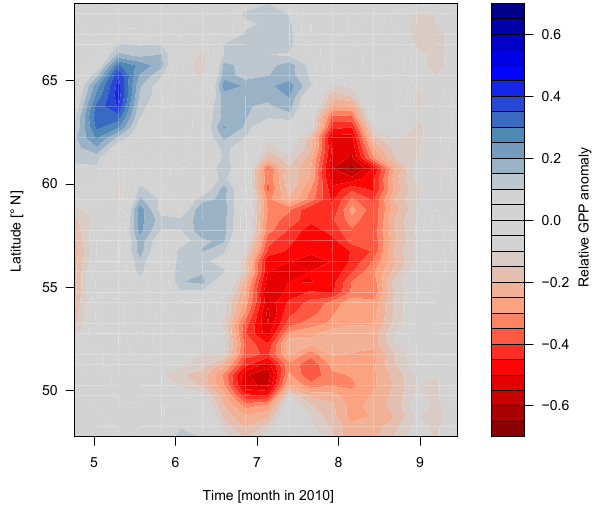
Figure B1. The longitudinal (30.25–60.25 ◦ E) average of the GPP anomalies during the RHW 2010, based on the Climate Re- search Unit observation-based climate variables (CRUNCEPv6, New et al., 2000) driven GPP product originating from FLUXCOM RS+METEO. Jung et al. (2017) show similar but weaker compen- sation effects; 28% of the negative GPP response to the RHW is compensated based on the shown latitude–longitude